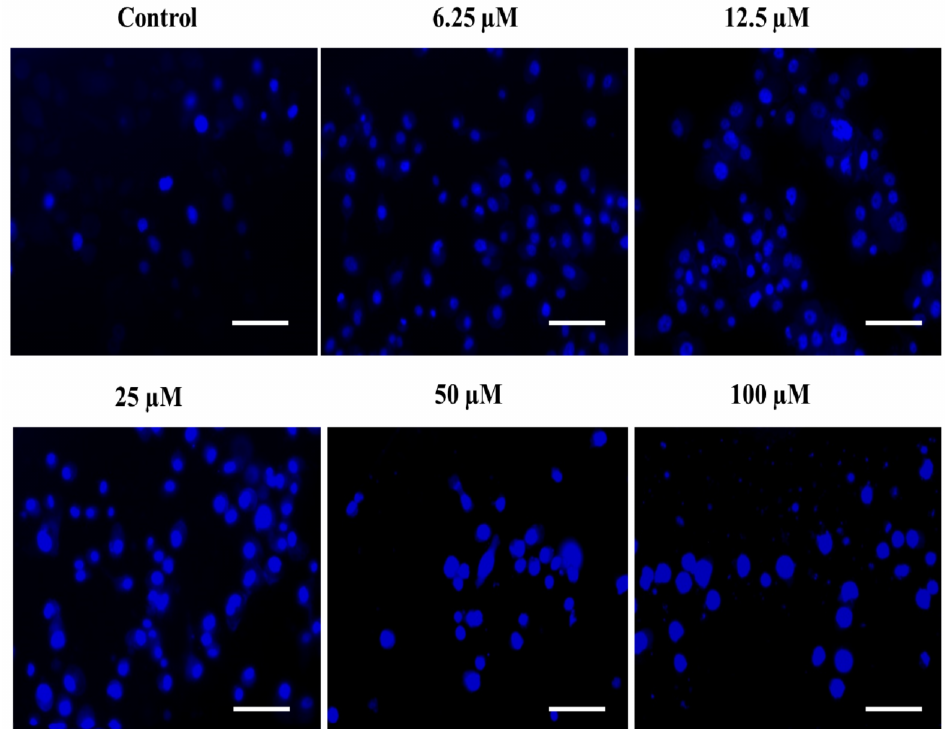
Figure 9. The substituted SOX ( 4a ) stimulates nuclear condensation/apoptosis in PC-3 cells. The PC-3 cells were challenged with varying doses of 4a (0.0–100 µ M) and incubated for 24 h and then stained with DAPI, and the DAPI-specific fluorescence was captured using a blue filter in a FLoid TM Imaging station (Thermo-Scientific, Waltham, MA, USA). Scale bar: 100 µ